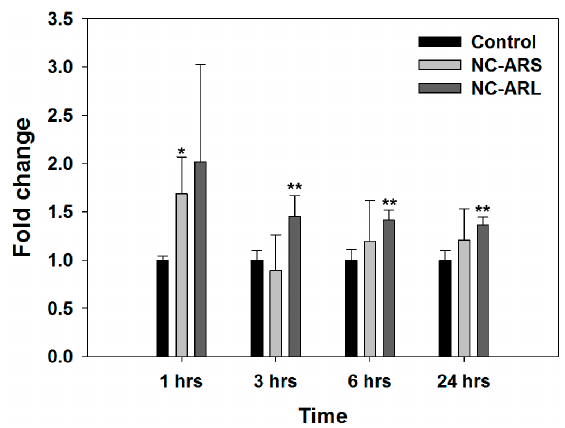
Figure 3. NCs induce endothelial cell permeability in vitro . Quantitative transwell assay to measure HUVEC permeability showed increased permeability after treating with NCs. ( * p < 0.05, ** p < 0.01 relative to control).